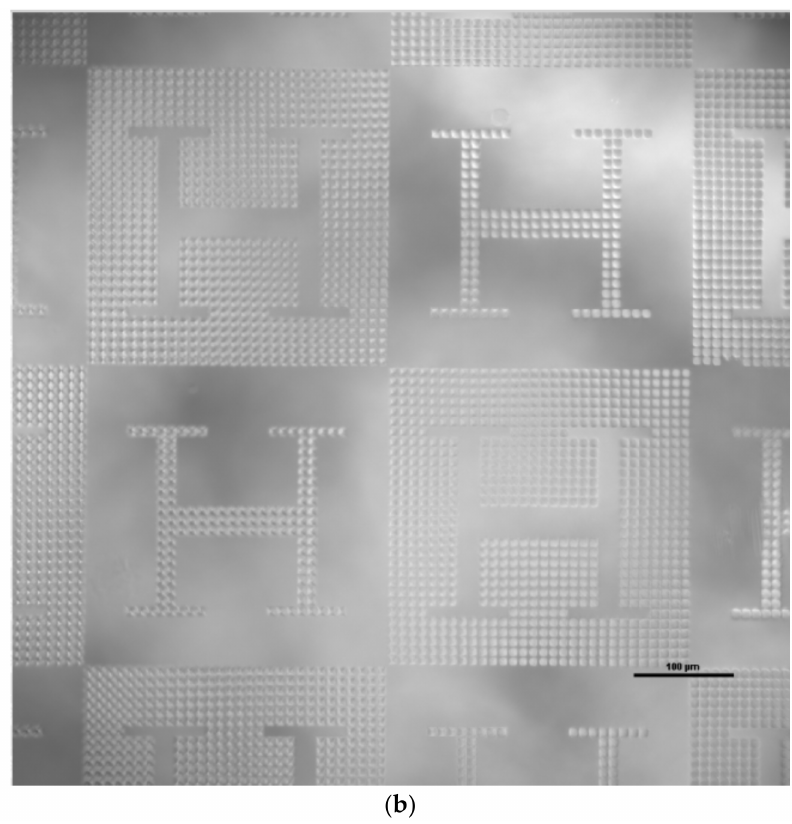
Figure 4. ( a ) 3T3 fibroblast cells after 40 min of culture upon a microtextured sample showing how cells organized due to the presence of topographical transitions. ( b ) Sample after final washing with PBS (almost all cells are